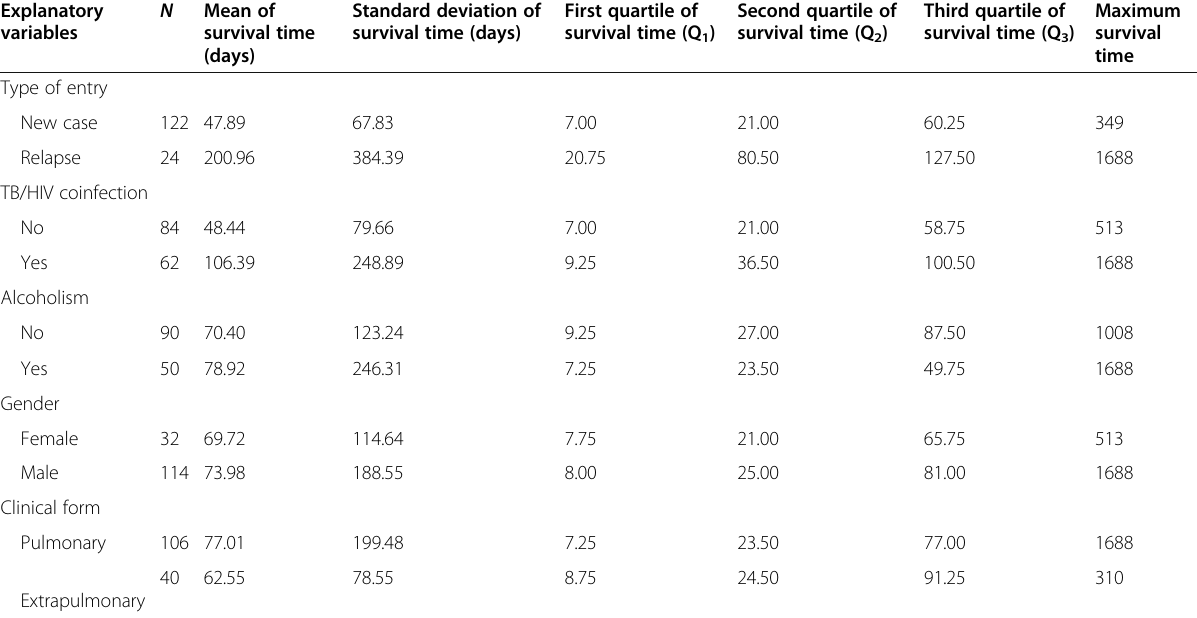
Table 3 Survival time according to each factor considered for the Cox proportional hazards regression model, Curitiba-Brazil Explanatory